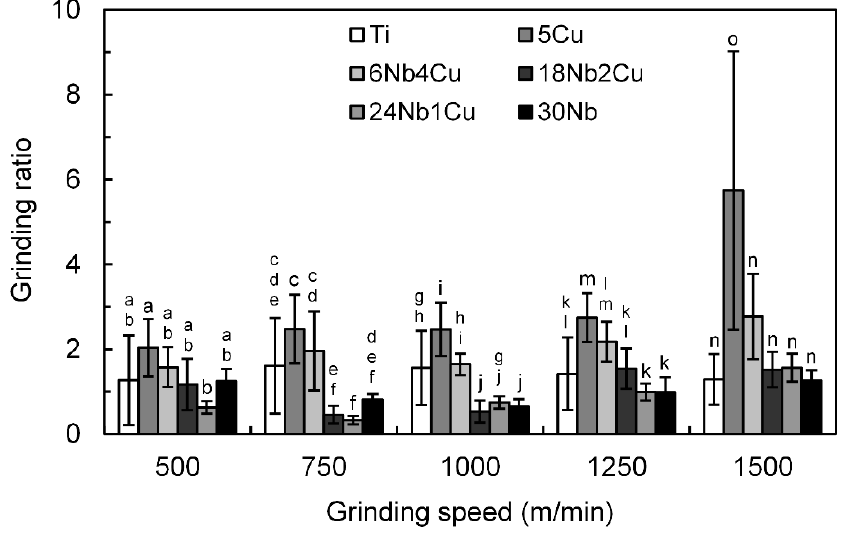
Figure 4. Grinding ratios for Ti − Nb − Cu alloys. At a particular grinding speed, identical letters indicate a statistically insignificant difference ( p > 0.05) between the grinding ratios for titanium and the alloy, whereas different letters indicate a statistically significant difference.